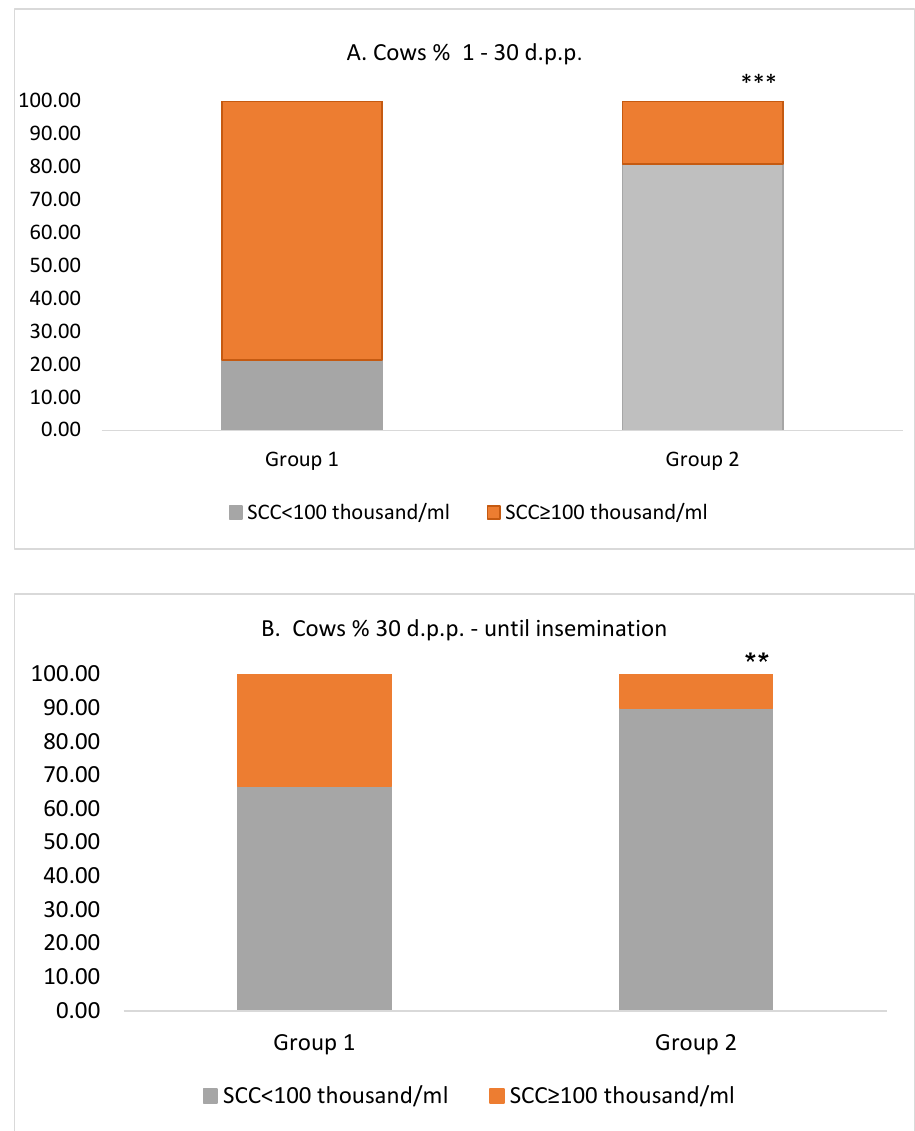
Figure 3. Relationship of milk somatic cell counts (SCC) with milk lactose level. ( A ). 1–30.p.p., ( B ). From 30 d.p.p. until insemination. Group 1—milk lactose < 4.70%, Group 2—milk lactose ≥ 4.70%. SCC—milk somatic cell count. The association between group and SCC of milk is statistically significant—** P < 0.01, *** P < 0.001.